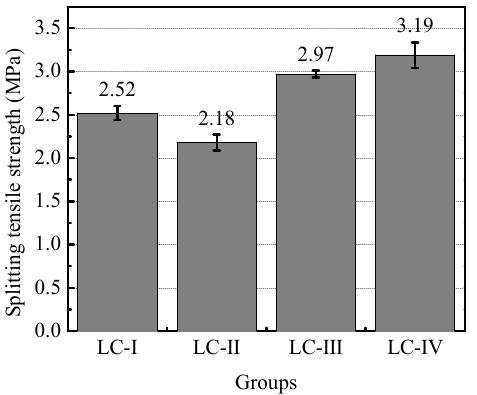
Figure 3. Splitting tensile strength of specimens in four groups.